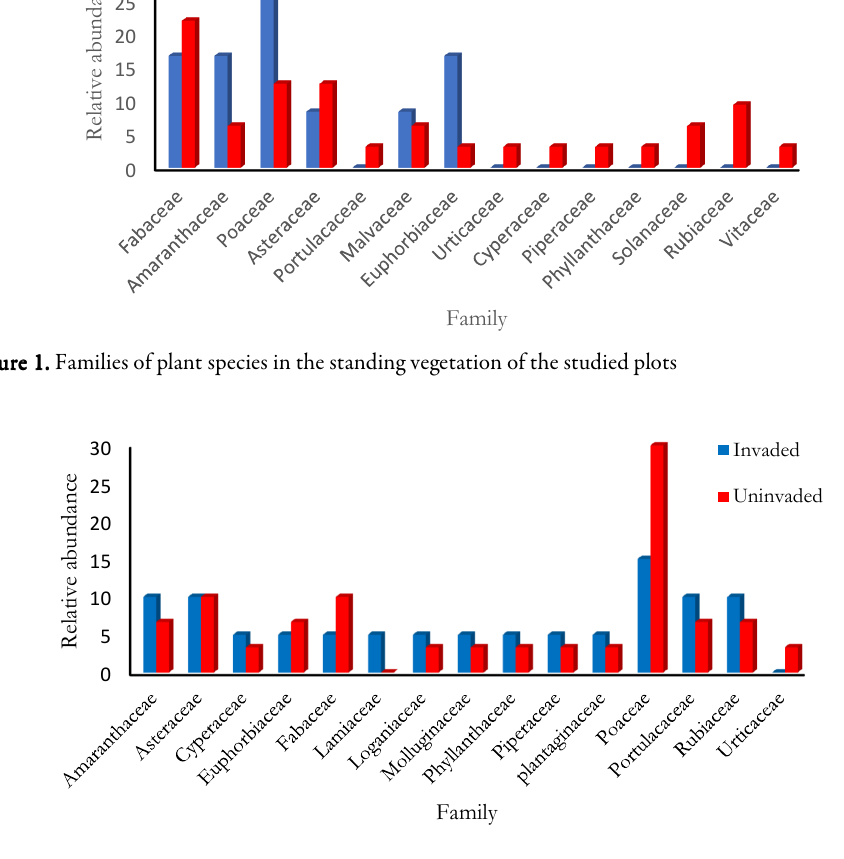
Figure 2. Families of plant species recruited from the seed bank at 0-15 cm